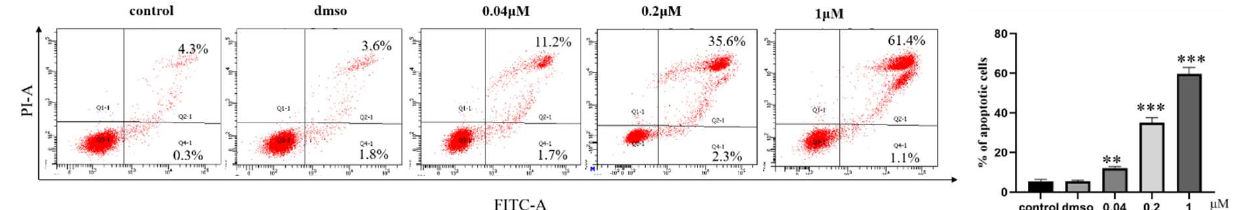
Figure 4. The percentage of cell apoptosis in A375 cells affected by different concentrations of CHJ04022R through flow cytometry using an Annexin V-FITC Apoptosis Detection Kit. All data were expressed as the mean ± SEM. ** p < 0.01, *** p < 0.001 compared to the control group.